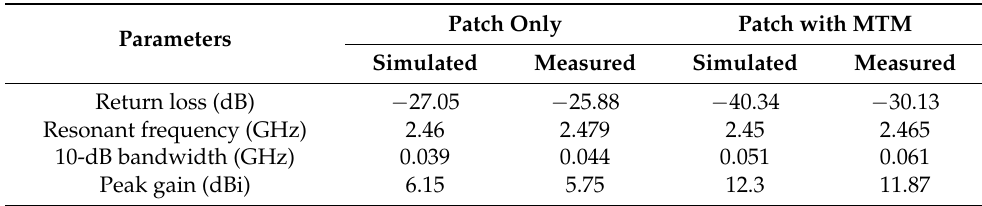
Figure 10. Simulated and measured peak gain of the patch antenna with and without MTM super- strate. Table 2. Simulated and measured performances of the patch antenna with and without MTM su- perstrate.